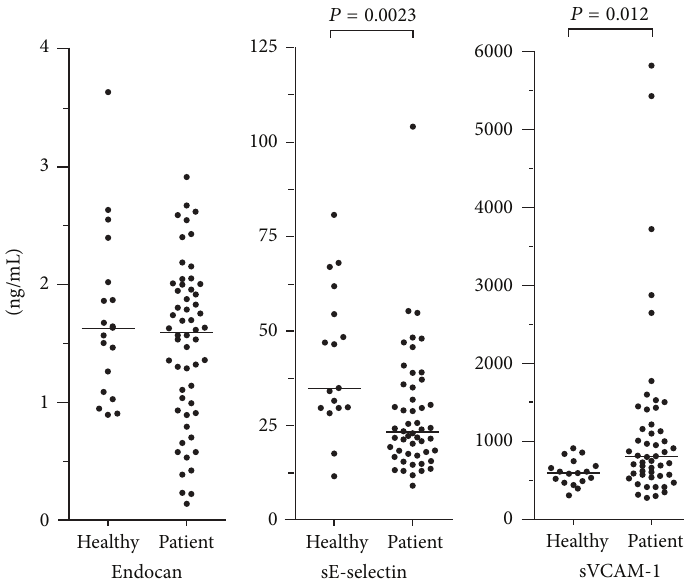
Figure 1: Serum levels of soluble adhesion molecules derived from endothelial cells (endocan, E-selectin, and VCAM-1) in healthy controls (healthy) and in consecutive/unselected patients prior to pretransplant conditioning therapy and allogeneic stem cell transplantation. A total of 56 patients were studied (endocan), but VCAM and E-selectin levels were available only for 50 consecutive/unselected